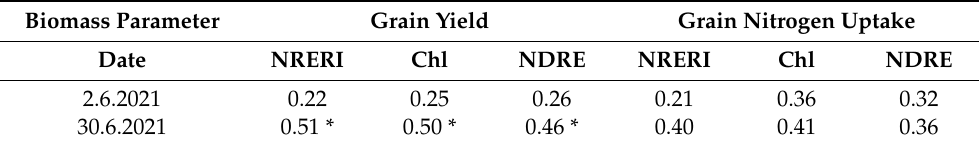
Table 3. Pearson´s correlation coefficients between grain yield and vegetation indices (NRERI, Chl and NDRE) from sampling points on June 2 and 30, 2021.